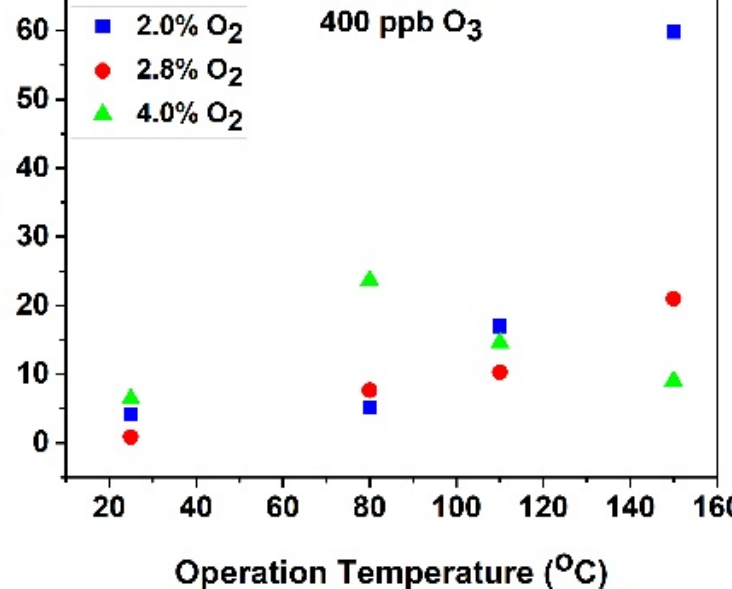
Figure 7. Sensitivity of rf-sputtered NiO:Al films grown with different O 2 content in plasma as a function of operating temperature.